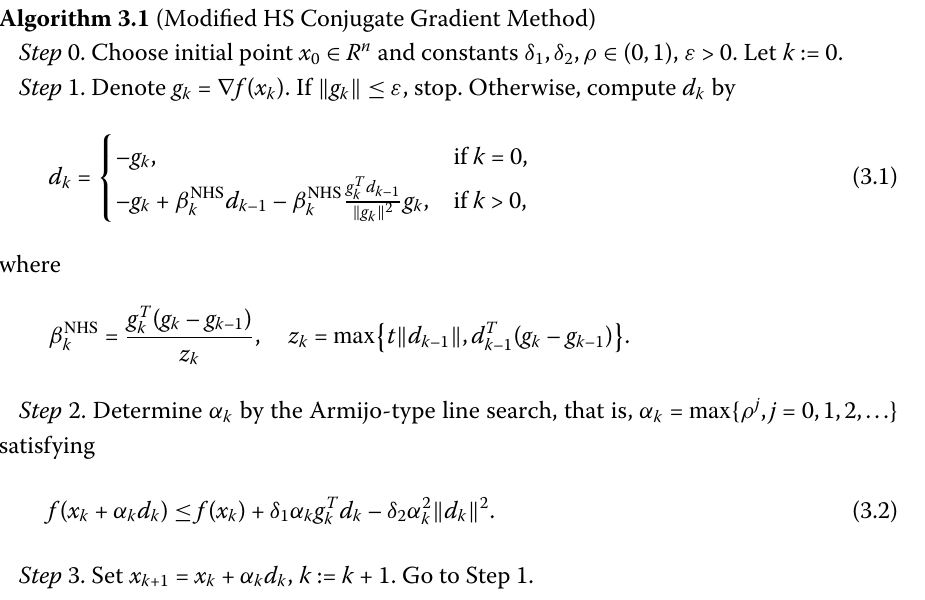
Algorithm 3.1 (Modified HS Conjugate Gradient